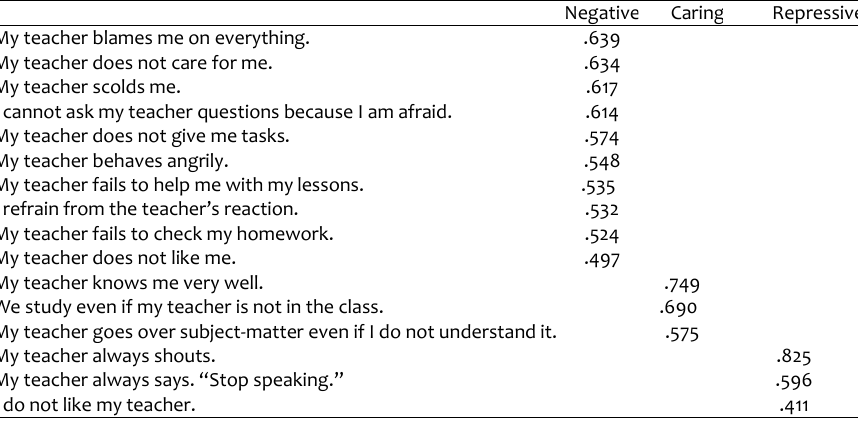
Table 3- Rotated Components Matrix after Factor